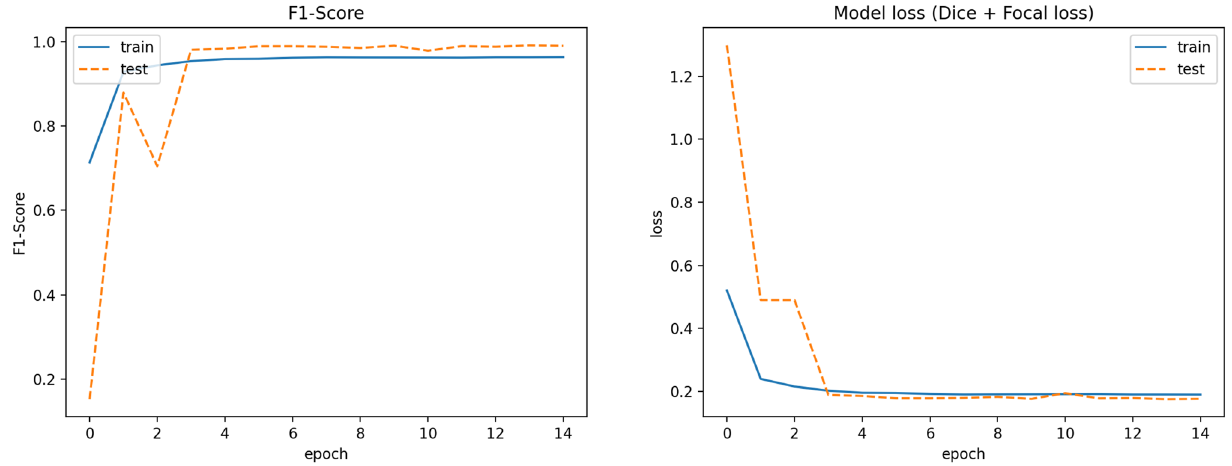
Figure 6. The trend of network convergence in terms of F1-score and corresponding loss